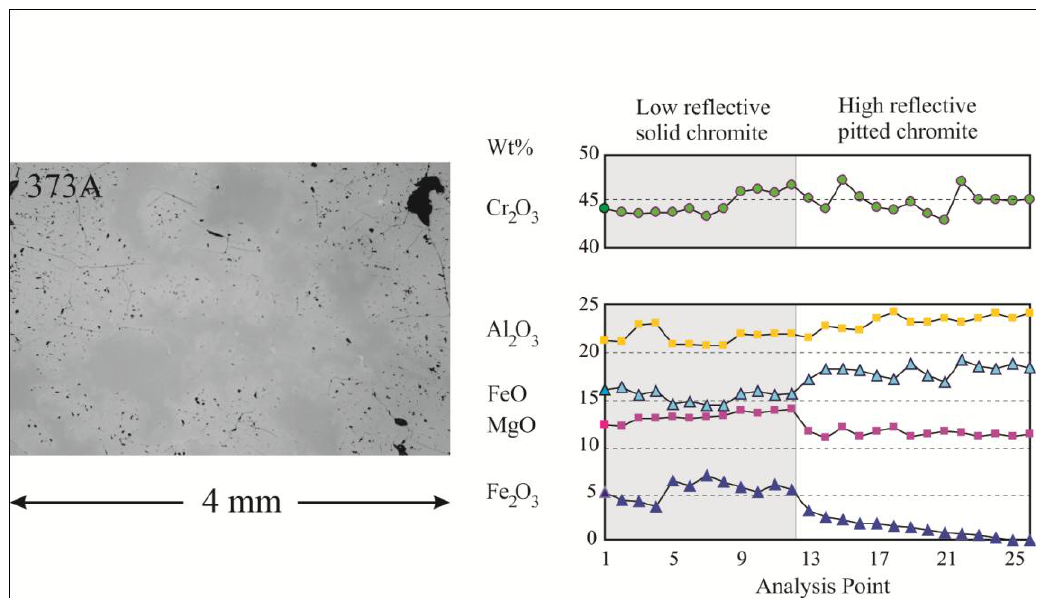
Figure 6. Chromite alteration patterns in laterite hosted chromitite CHR-2. The dark, solid chromite may represent the primary magmatic composition. The more reflective, pitted chromite is believed to be a result of the deep chemical weathering under lateritic conditions.